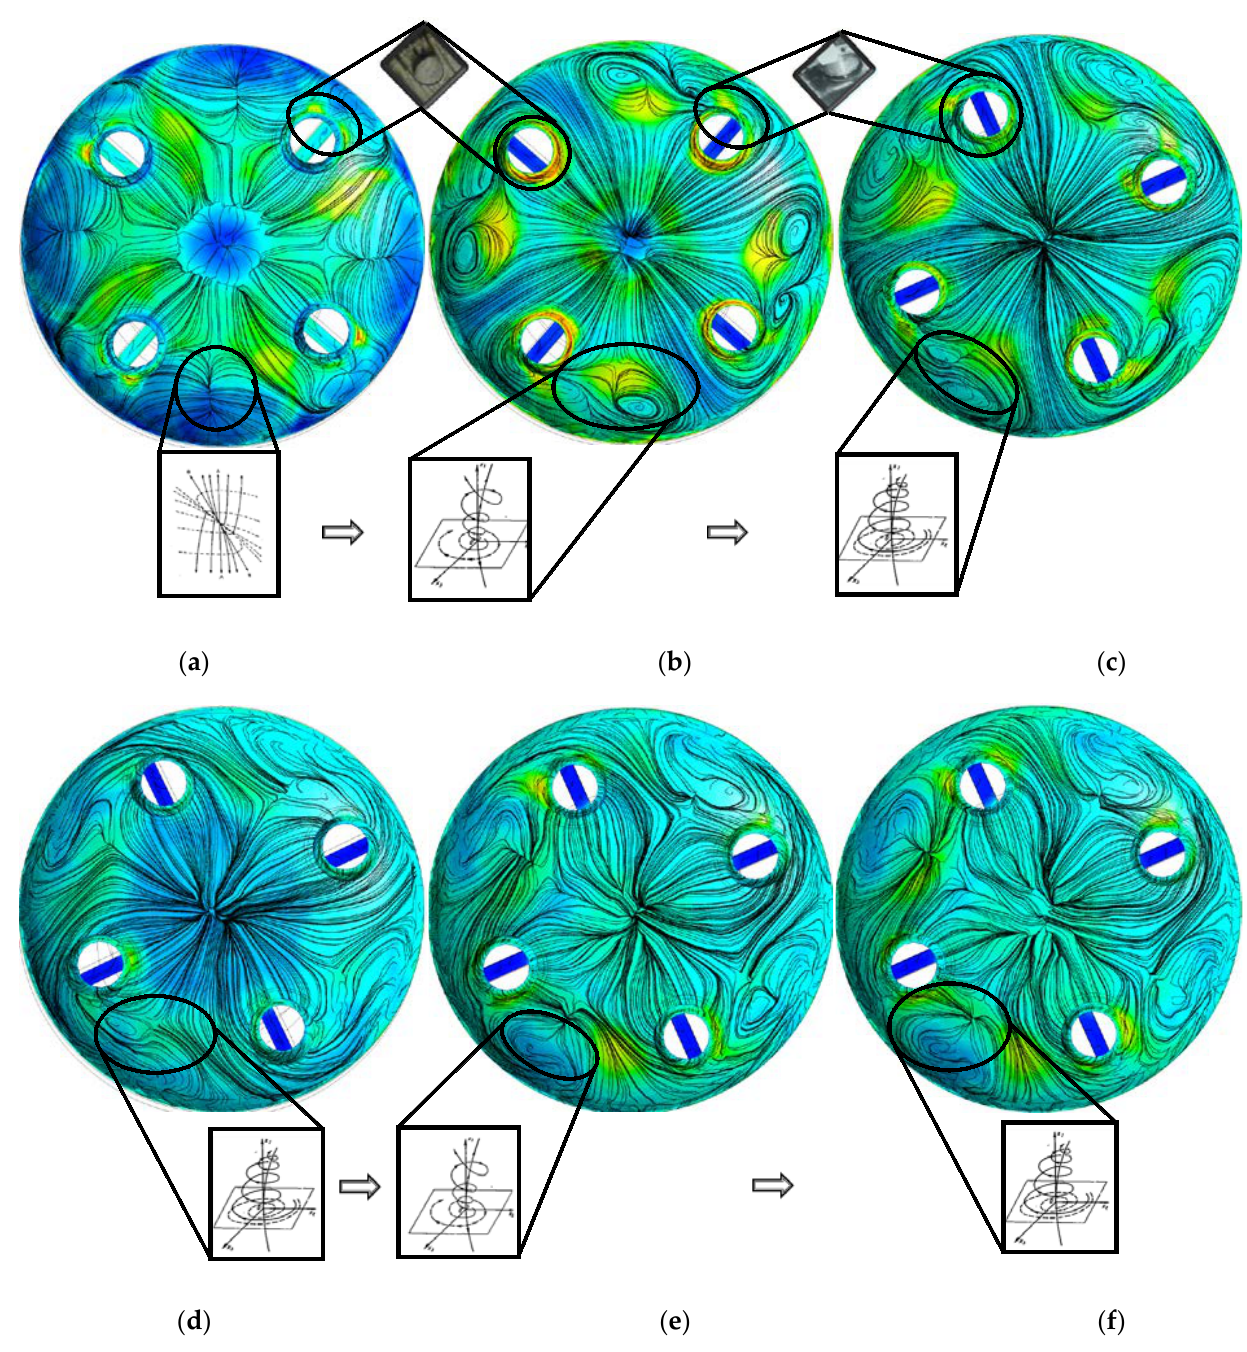
Figure 3. Transformation of peripheral structures in the vicinity of the nozzle cover at PP operation: black lines are current lines, color counter is a field of heat transfer coefficient (minimal is a blue color, maximal is a red color), where ( a ) for time 0.0001[s], ( b ) for time 0.0002[s],( c ) for time 0.0003[s], ( d ) for time 0.0004–0.0005[s], ( e ) for time 0.0006[s] and ( f ) for time 0.0007–0.001[s].